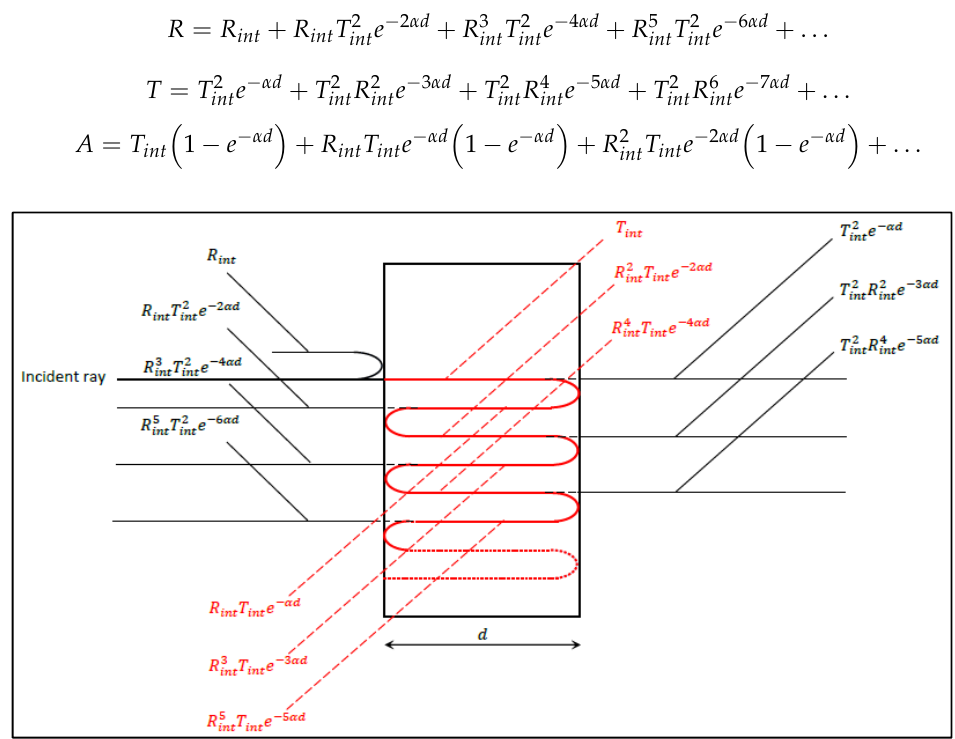
Figure 1. Multiple ray reflections and transmissions of a normally incident light beam inside an optically thick plane-parallel dielectric plate.